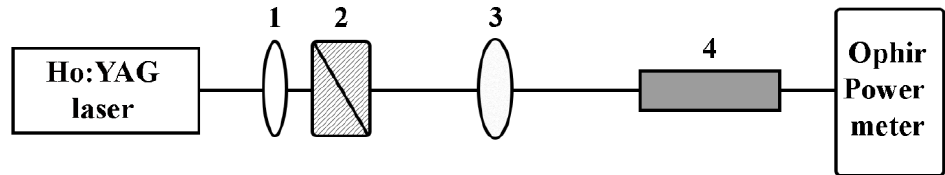
Figure 9. The block-scheme of laser system used in experiment (LIDT test): 1—polarizer; 2—beam- splitter cube (BSC); 3—focusing lens with focal distance 200 mm; 4—investigated ZGP element.